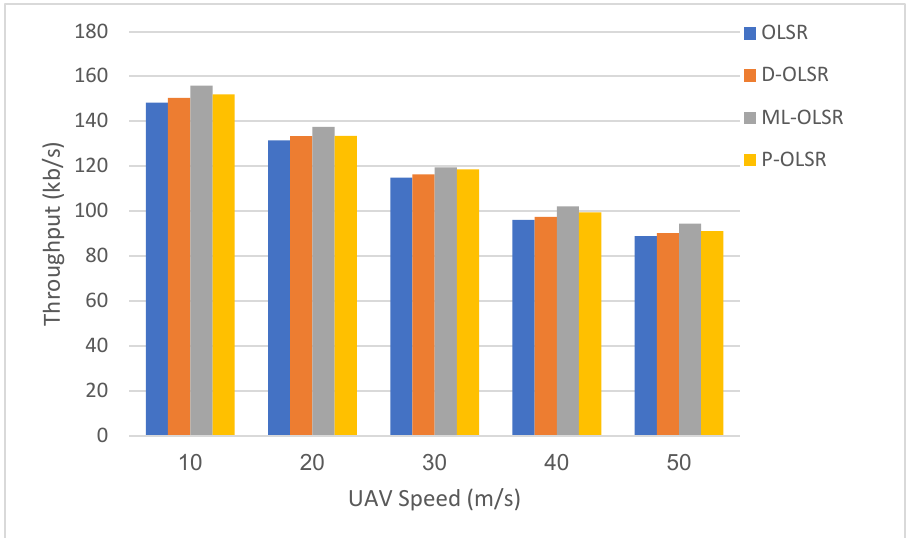
Figure 9. Throughput vs. speed of UAVs.